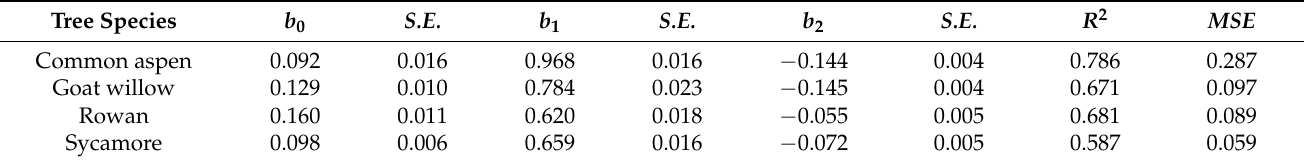
Figure 3. Modeled relationships between bark thickness and stem base diameter D 0 for common aspen ( a ), goat willow ( b ), rowan ( c ) and sycamore ( d ), at different predefined vertical distances H g from the ground level (blue: H g = 50 cm, orange: H g = 100 cm, red: H g = 150 cm, brown: H g = 200 cm, green: H g = 250 cm), see Table 4 for formulas and statistical characteristics of derived regression models. Table 4. Relationships between bark thickness T b and diameter D 0 and the vertical distance from the ground ( H g ) for four broadleaved tree species separately described by the formula: T b = b 0 D 0 b1 H gb2 (where T b is in mm, D 0 in mm, H g in cm)—regression coefficients b 0 , b 1 , b 2 , their standard errors ( S.E. ), coefficient of determination ( R 2 ), mean squared error (MSE). All calculated p -values of derived regression coefficients were < 0.001.